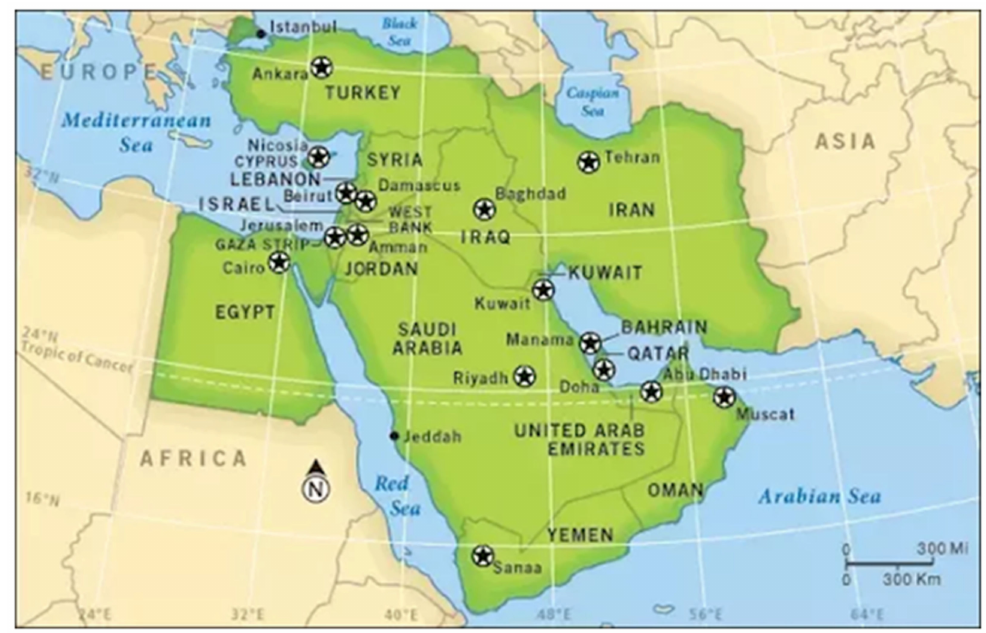
Figure 1. Geographical map showing the location of countries included in the Middle East Region. Reproduced with permission from Associated Marketing